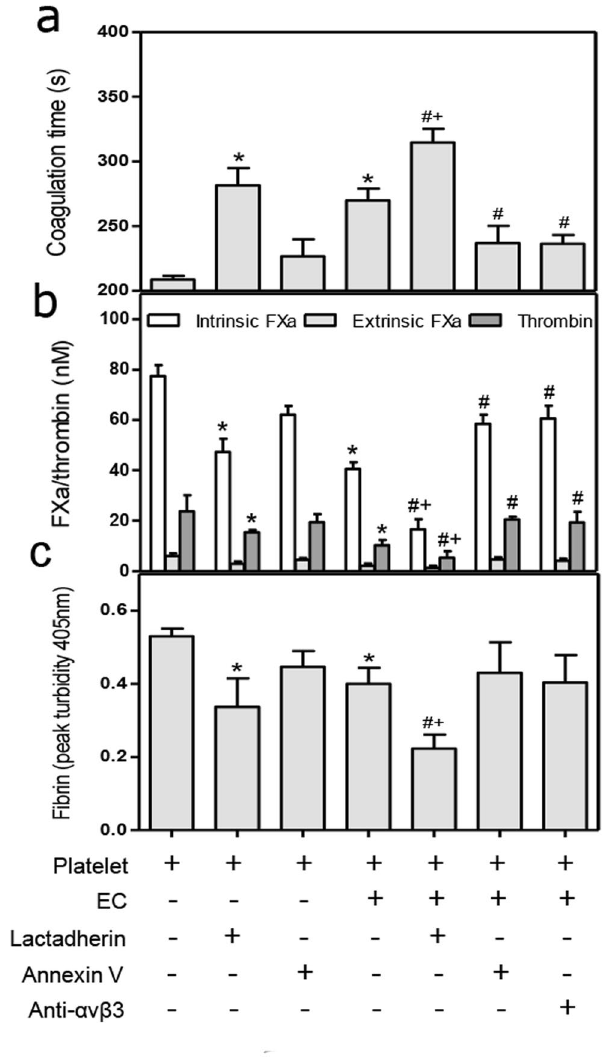
Figure 7. Effect of lactadherin-mediated phagocytosis on procoagulant activity and fibrin formation. Platelets from patients (n = 10) were collected. They were untreated, treated with lactadherin or annexin V, or incubated with ECs for 1 h in the presence or absence of lactadherin, annexin V, or anti- α v β 3 antibody. The untreated or treated platelets were for further evaluations of ( a ) coagulation time; ( b ) intrinsic and extrinsic FXa and thrombin generation; ( c ) and fibrin turbidity which was measured as terminal A 405 at half an hour. Platelets without any treatment were used as control. * P < 0.05 versus control; # P < 0.05 versus Platelet ( + ) ECs ( + ); + P < 0.05 versus Platelet ( + ) lactadherin ( + ). Each value represents mean ± SD.